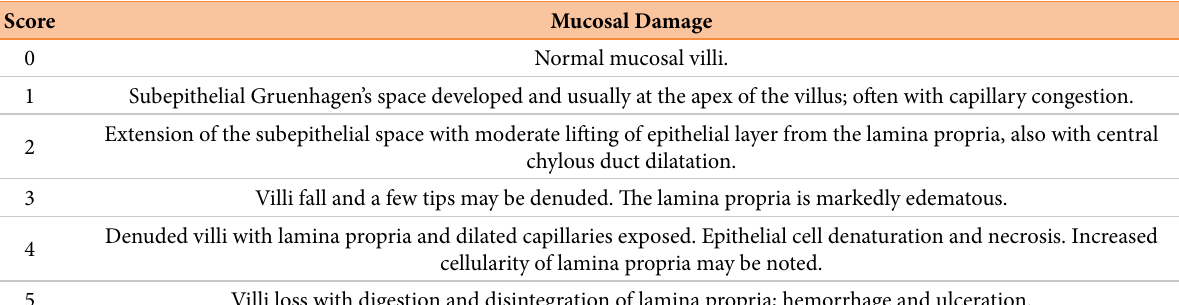
Table 2 - Pathological scoring criteria for small